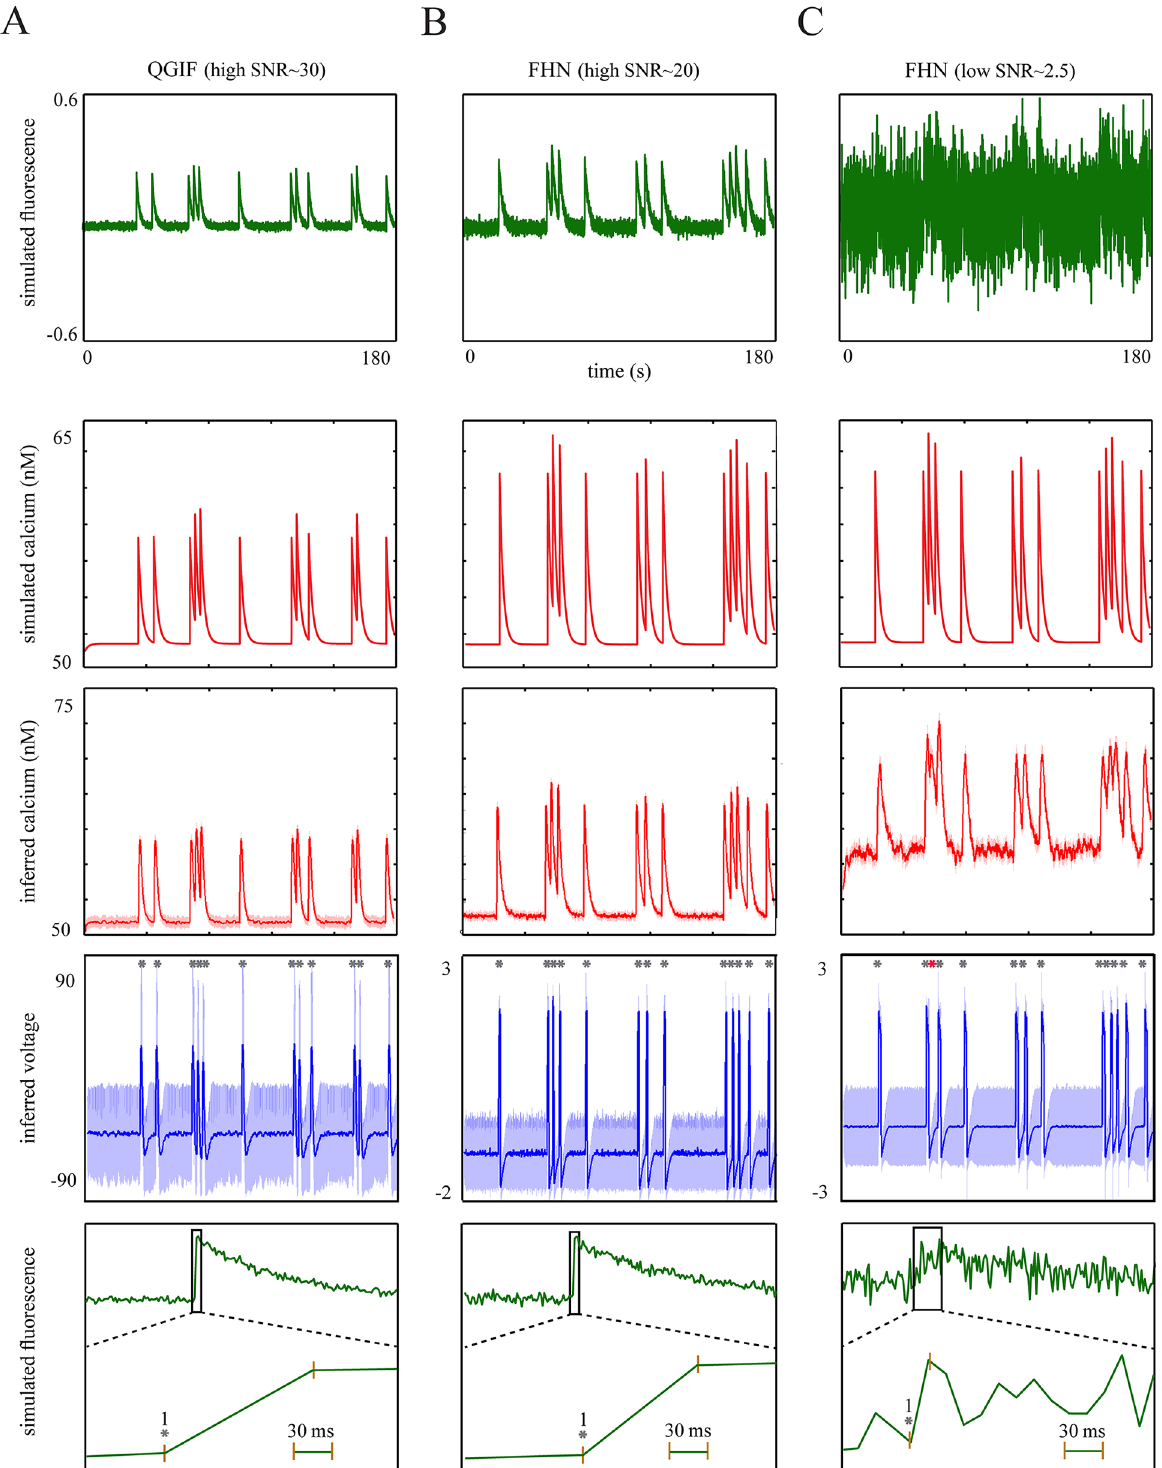
Fig 4. Results of the proposed approach for synthetic single-spike-evoked transients with fast rise times. ( A ): QGIF model, ( B ): FHN model with high SNR, ( C): FHN model with low SNR. ( A - C ) Inferring neuronal dynamics from transients with fast rise times (e.g. 3 ms ). The fluorescence traces (first row) and [Ca 2+ ] kinetics (second row) were simulated by using ( A ) QGIF and ( B and C ) FHN generative models. Inverting each model for its corresponding trace